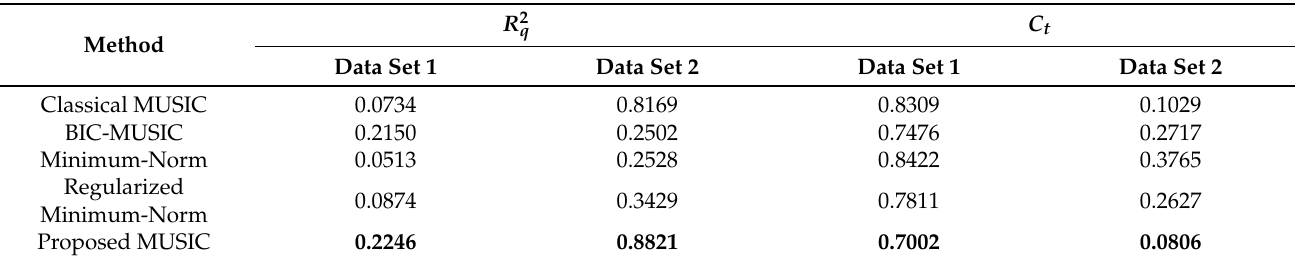
Table 3. R- squared and Completeness